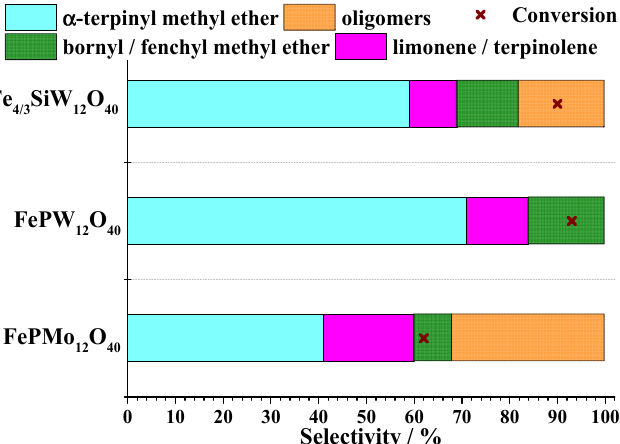
Figure 10. Impacts of Keggin anion on the conversion and selectivity of Keggin HPA iron salts phosphotungstate-catalyzed reaction of β -pinene with methyl alcohol (adapted from ref. [34]) a . a Reaction conditions: β -pinene (3.8 mmol), CH 3 OH (14.3 mL), temperature (333 K), catalyst (0.50 mol%), volume (10 mL).